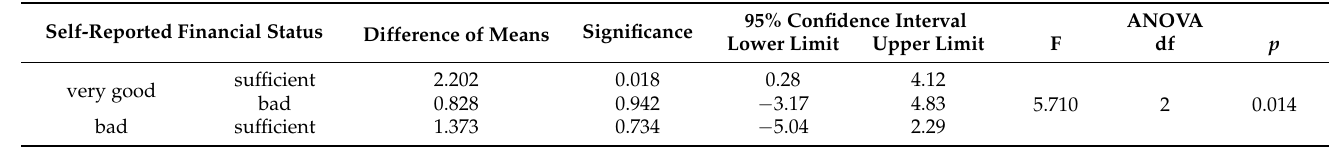
Table 4. Comparison of EAT severity depending on financial